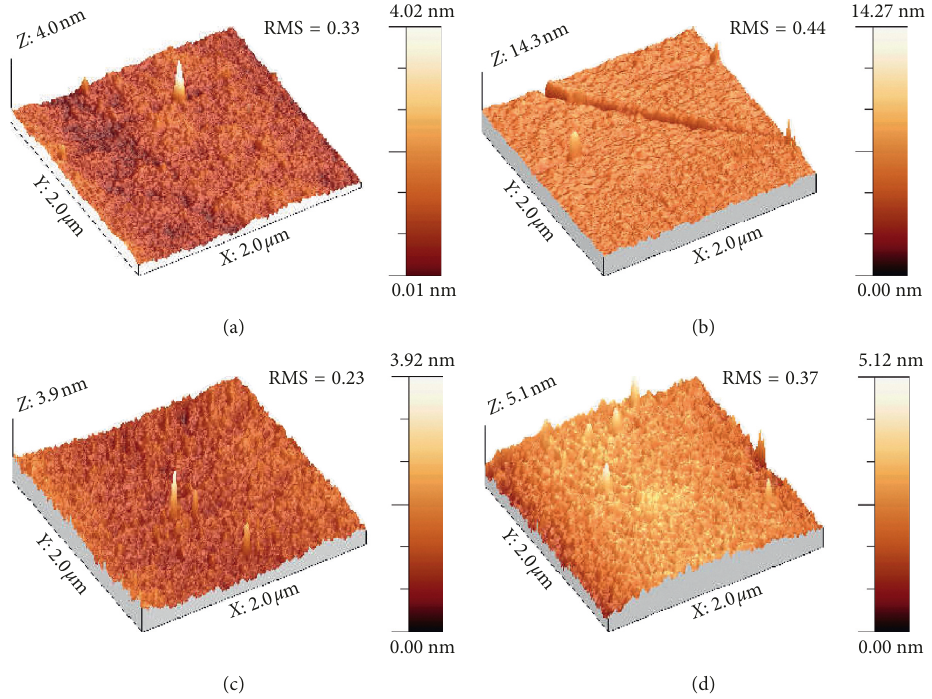
Figure 5: AFM topographic images: (a) SbSe; (b) annealed SbSe; (c) SbSe (1nm)/SiO (9nm); (d) annealed SbSe (1 nm)/SiO